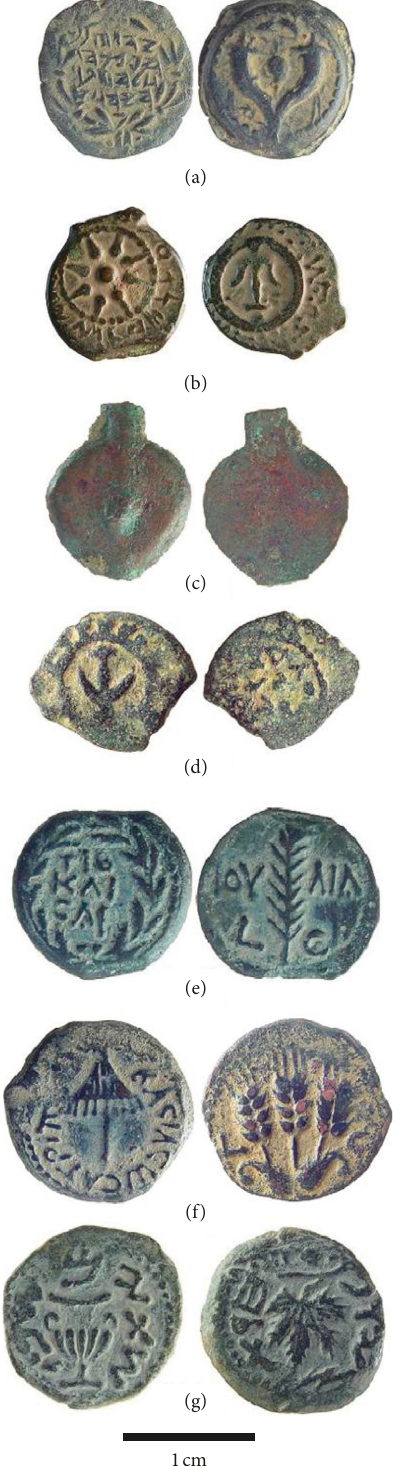
Figure 6: Judaean prutah analyzed by TOF-ND: (a) GBC-1133, JH � John Hyrcanus I (135–104 BCE); (b) GBC-1152, AJ � Alexander Jannaeus (104–76 BCE); (c) US � unstruck blank or flan from the time of Jannaeus and/or Herod I; (d) GBC-1174 to 1177, HG � Herod I, the Great (40–4 BCE); (e) GBC-1339, VG � Valerius Gratus (15–26 CE); (f) GBC-1244, Herod Agrippa I (37–44 CE); and (g) GBC-1360, JW � Jewish War/Revolt, year 1 (66–70 CE). GBC � Ref.